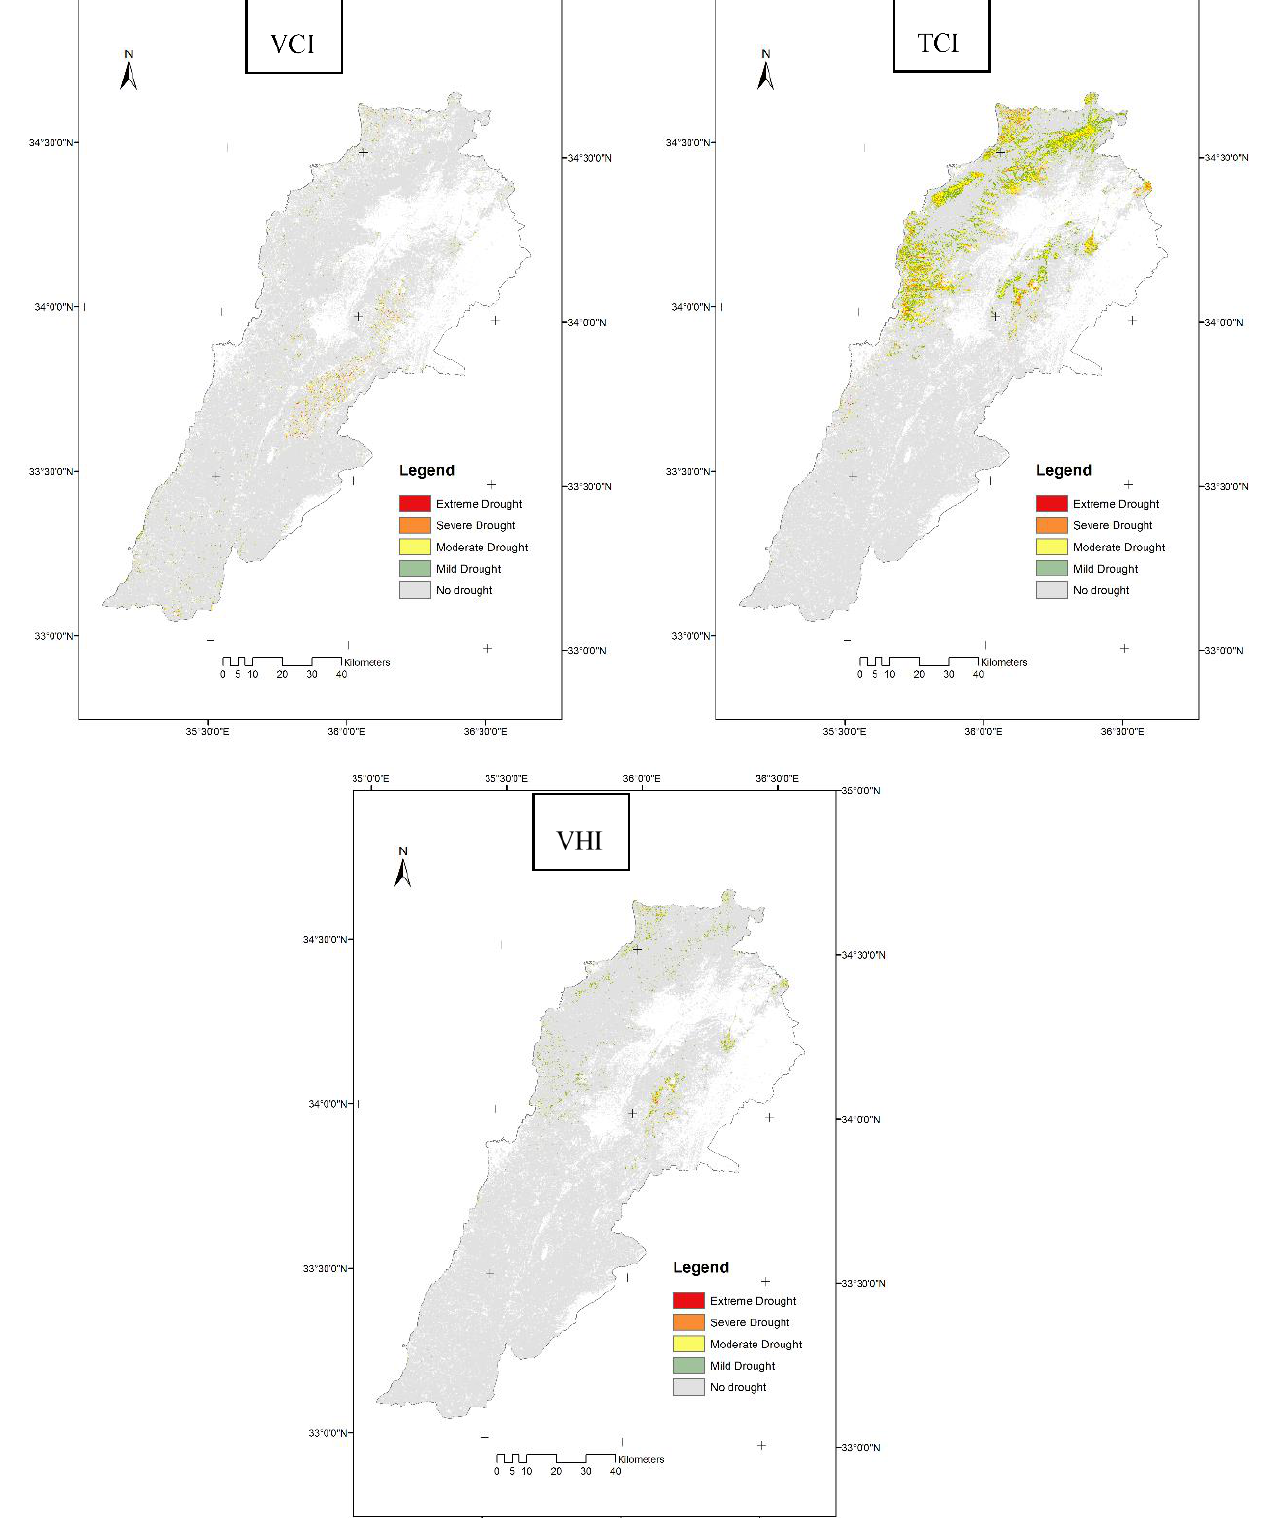
Figure 6. TCI ( upper-left ), VCI ( upper-right ) and VHI ( bottom ) variations in Lebanon,